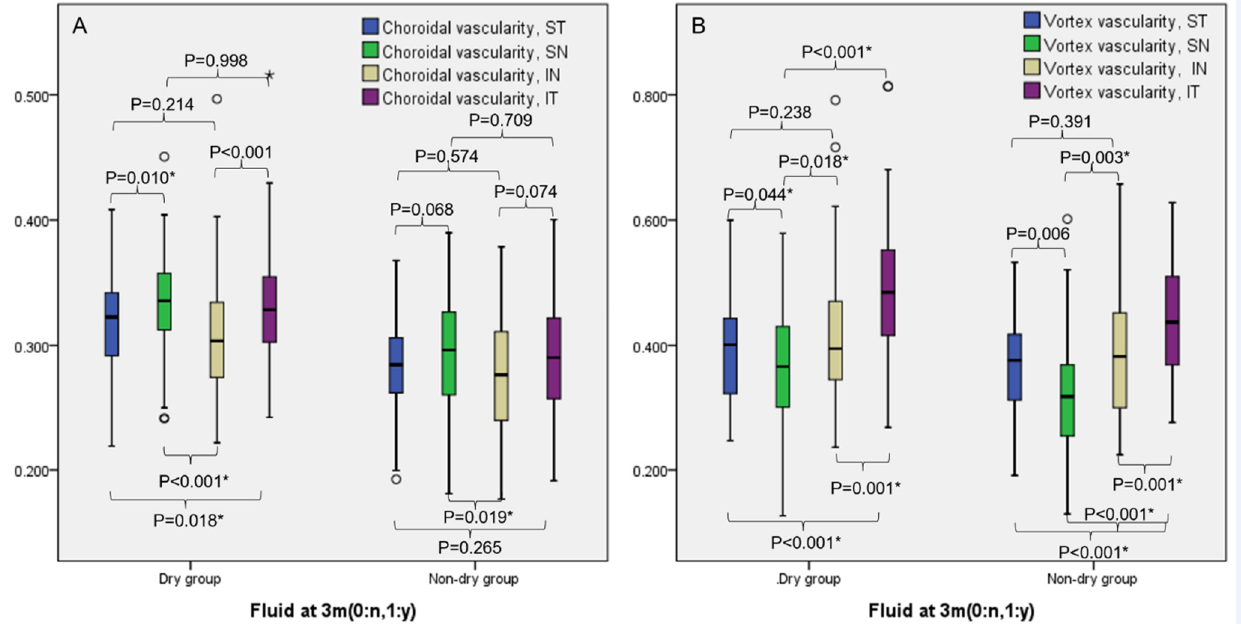
Figure 2. Comparison of choroidal vessel density (CVDs) of each quadrant measured on ultra-widefield indocyanine angiography between the dry and non-dry group. ( A ) CVDs of the superonasal (SN) and inferotemporal (IT) quadrants were higher than those of the superotemporal (ST) and inferonasal (IN) quadrants in both groups. ( B ) CVDs of the vortex ampullae were higher in the IT quadrant compared to other quadrants in both groups. *: p -value < 0.05.